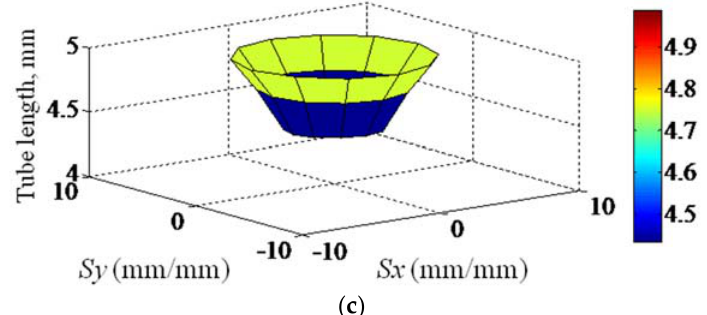
Figure 9. Spatial distribution of block element tube lengths l e of the cloak shell (Unit: mm): ( a ) tube length distribution around the cloak shell in the u e direction, ( b ) in the v e direction, and ( c ) in the w e direction.